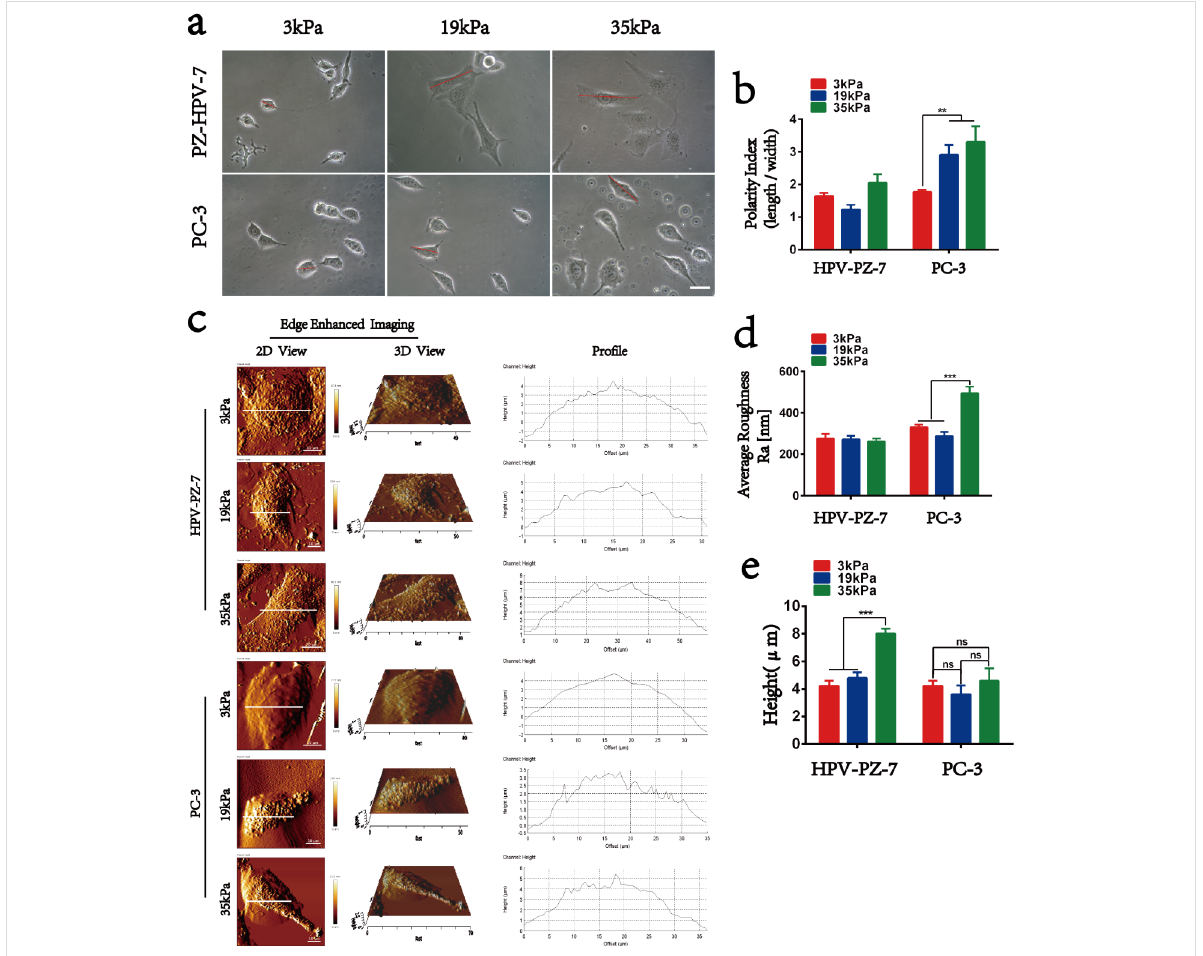
Figure 3: Morphological analysis showed different characteristics in different stiffness. (a) Phase-contrast microscopy imaging of PZ-HPV-7 and PC-3 cells on substrates with different stiffness, scale bar = 10 μ m. (b) Quantitative statistical graph of cell polarity index (length/width). (c) Atomic force microscopy imaging of HPV-PZ-7 and PC-3 cells on substrates with different stiffness. From left to right, the edge-enhanced images of cells are displayed, including two-dimensional and three-dimensional imaging and cell contour maps. (d) Quantitative statistics of the average surface rough- ness (Ra). (e) Quantification plot of cell height; “ns” means no difference, ** P < 0.01, *** P <